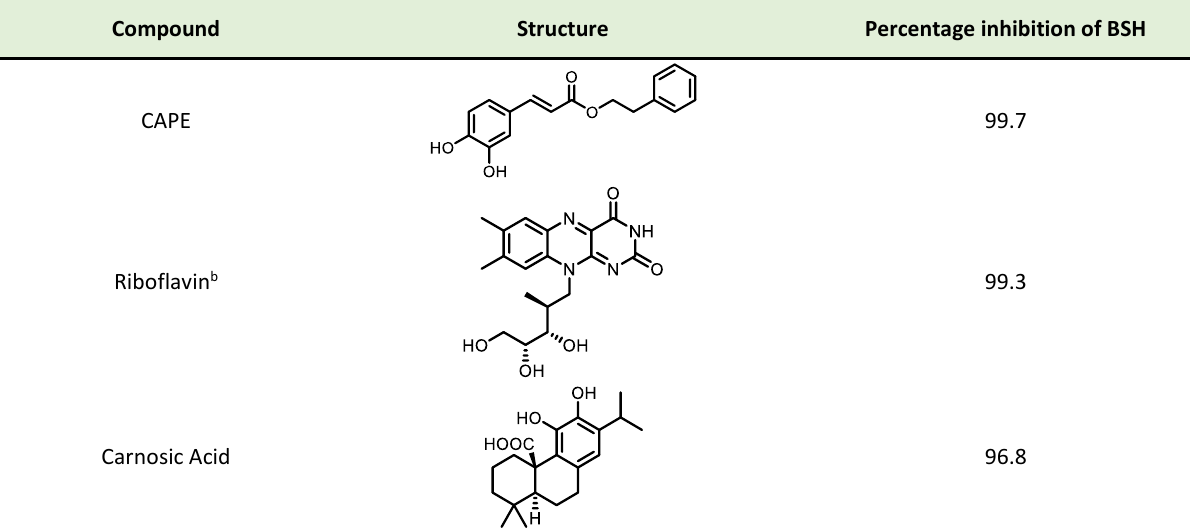
TABLE 2. Effect of inhibitors on BSH activity a